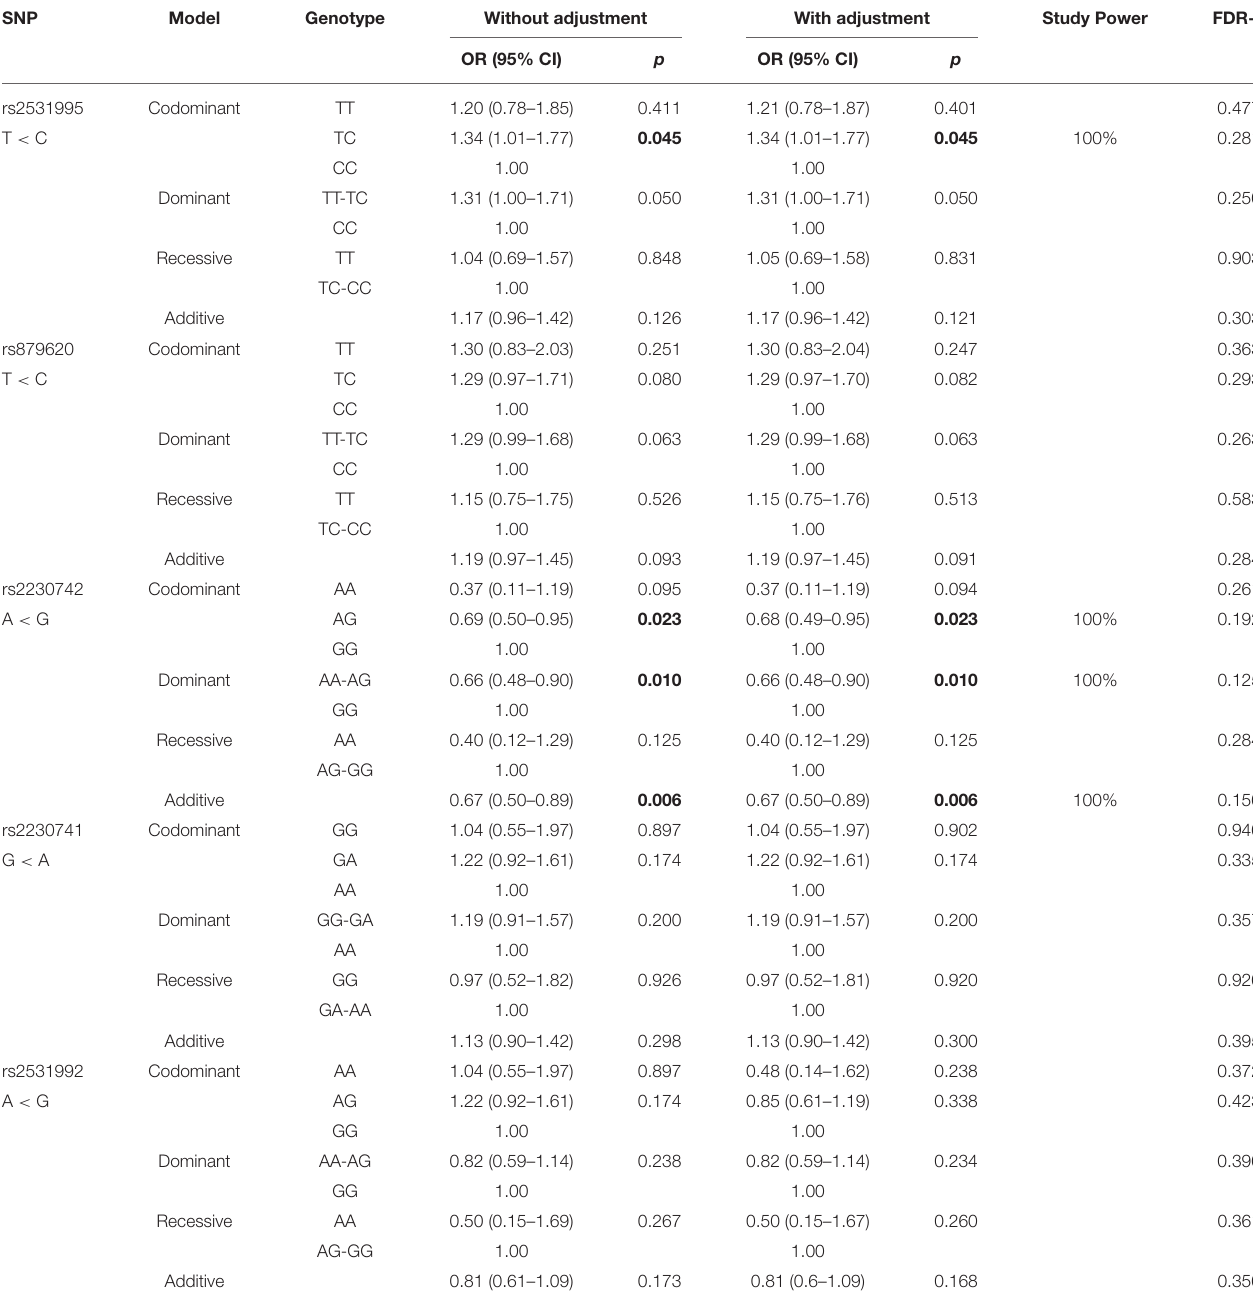
TABLE 3 | Associations between ADCY9 gene polymorphisms and hepatocellular carcinoma risk.